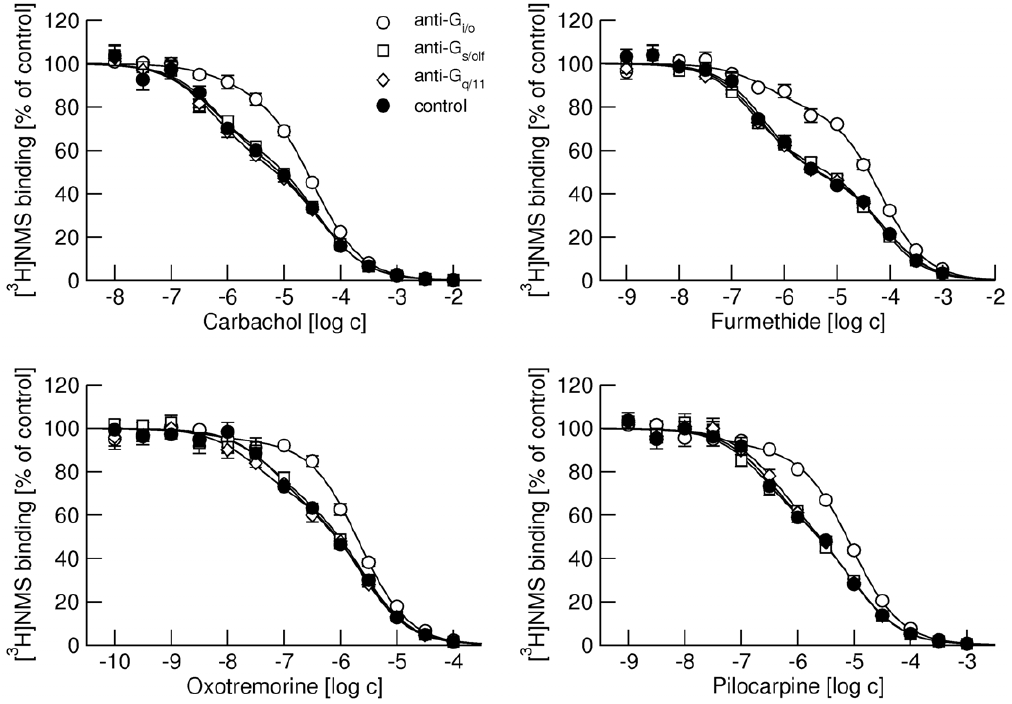
Data are means 6 S.E.M. From 3 experiments performed in quadruplicates. f low , fraction of low-affinity sites in percent; *, significantly different from control by t-test (P , 0.05).